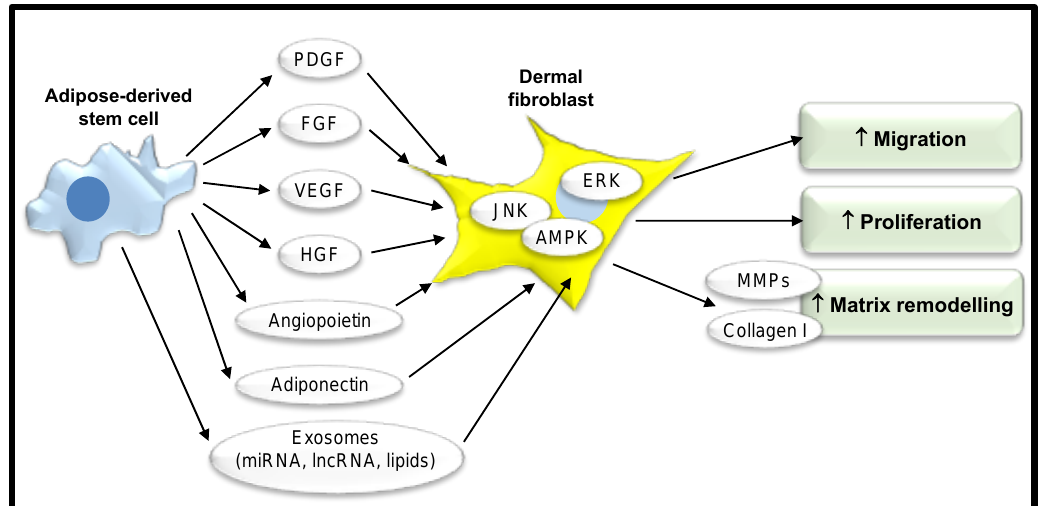
Figure 3. Adipose-derived stem cells promote wound healing. Adipose-derived stem cells have a complex secretome that includes, for example, growth factors and adipokines. These induce migration, proliferation, and matrix remodeling in neighboring dermal fibroblasts through various intracellular signaling pathways to enhance wound healing. PDGF, platelet-derived growth factor; FGF, fibroblast growth factor; VEGF, vascular endothelial growth factor; HGF, hepatocyte growth factor; ERK, extracellular signal-regulated kinase; JNK, c-Jun N-terminal kinase; AMPK, adenosine monophosphate protein kinase; MMPs, matrix metalloproteinases; miRNA, microRNA; lncRNA, long noncoding RNA. ASC CM has been shown to improve properties of wound healing in dermal fibroblasts when observed in vitro . One study showed that human keloid-derived fibroblast proliferation was reduced following treatment with human ASC CM in a BrdU proliferation assay [50]. This suggests that ASCs may downregulate proliferation of diseased fibroblasts causing problematic scarring via excessive ECM deposition in wounded skin. Cooper et al . demonstrated treatment with ASC CM increased dermal fibroblast migration in a scratch wound assay by 43% [45].